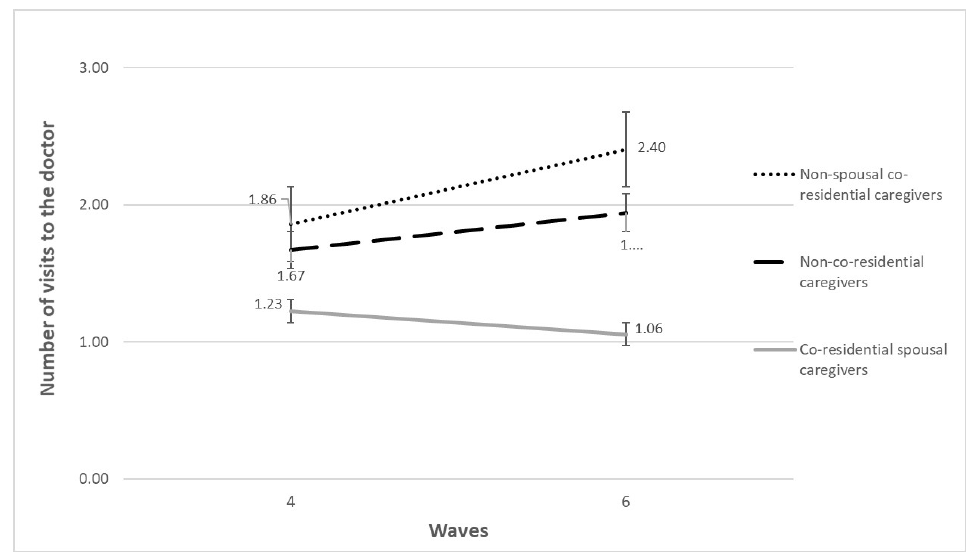
Figure 2. Changes in the number of visits to the doctor across waves, according to caregiver